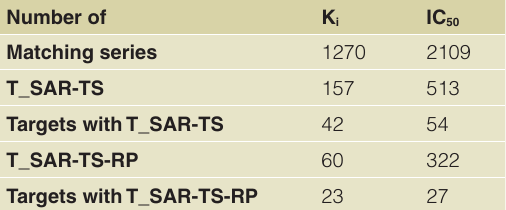
Table 3. Target-based SAR transfer series statistics.